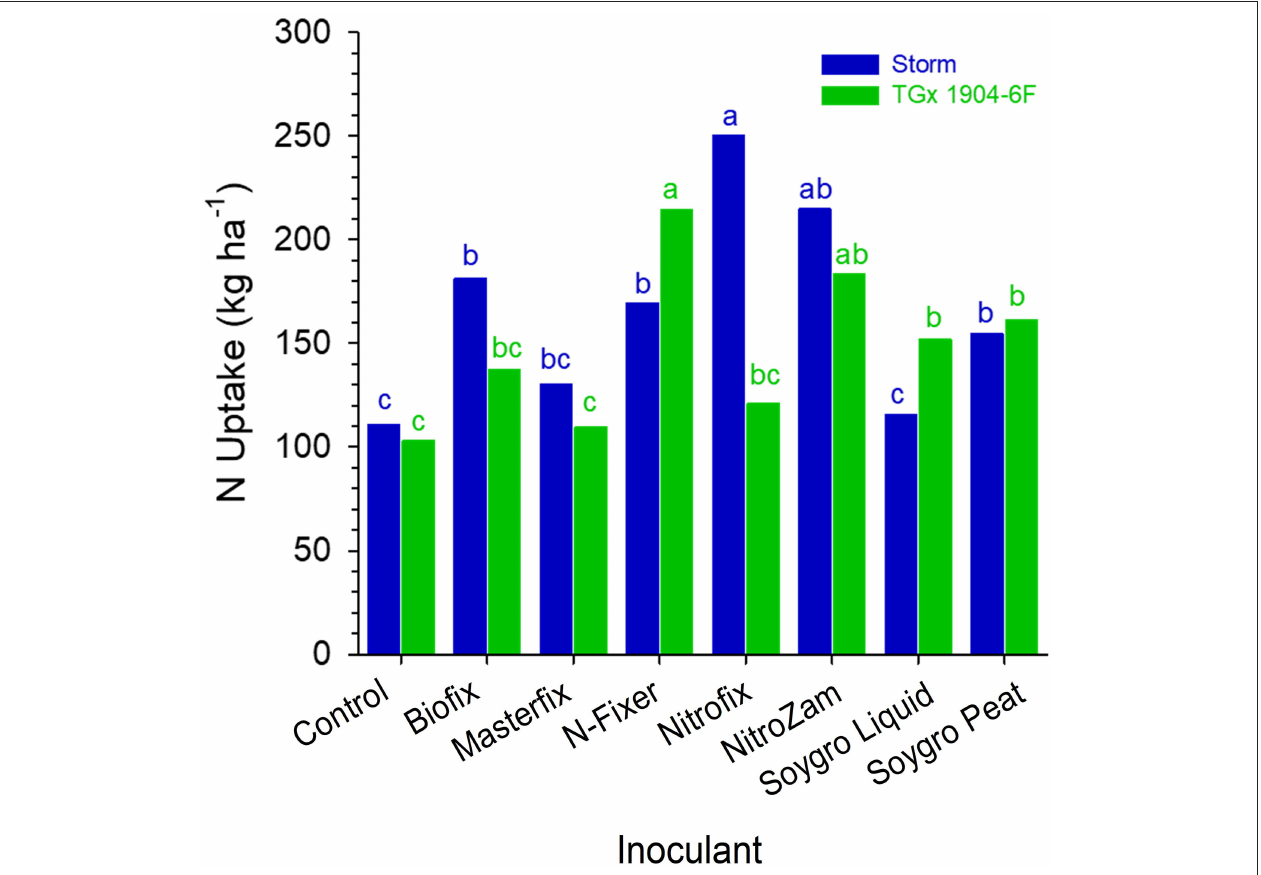
FIGURE 3 | N uptake by soybean at the beginning of podding (R3) stage in Nampula in 2016. Small letters on the bars indicate no significance while different letters show significant differences in means.